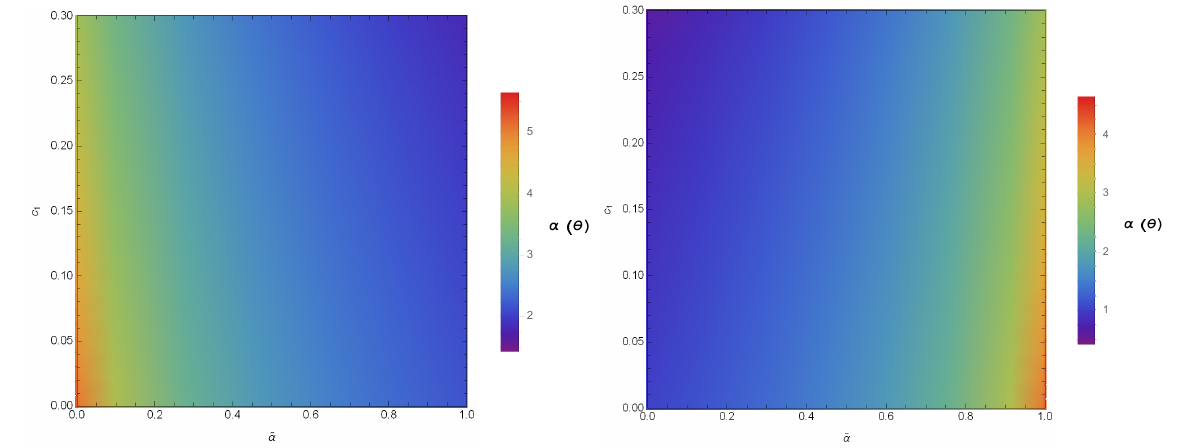
Figure 4. Color-indexed variations of the SD angle ( α ( θ ) ) with ˜ α and c 1 ( left ) for PPL and ( right ) for √ PPM. Here, we set c 0 = 3 c 1 d + 1, d = 1, and Λ = −